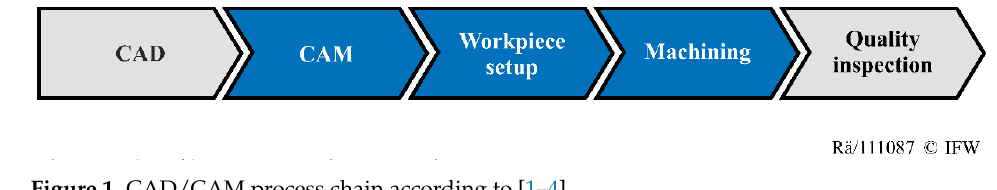
Figure 1. CAD/CAM process chain according to [1–4].